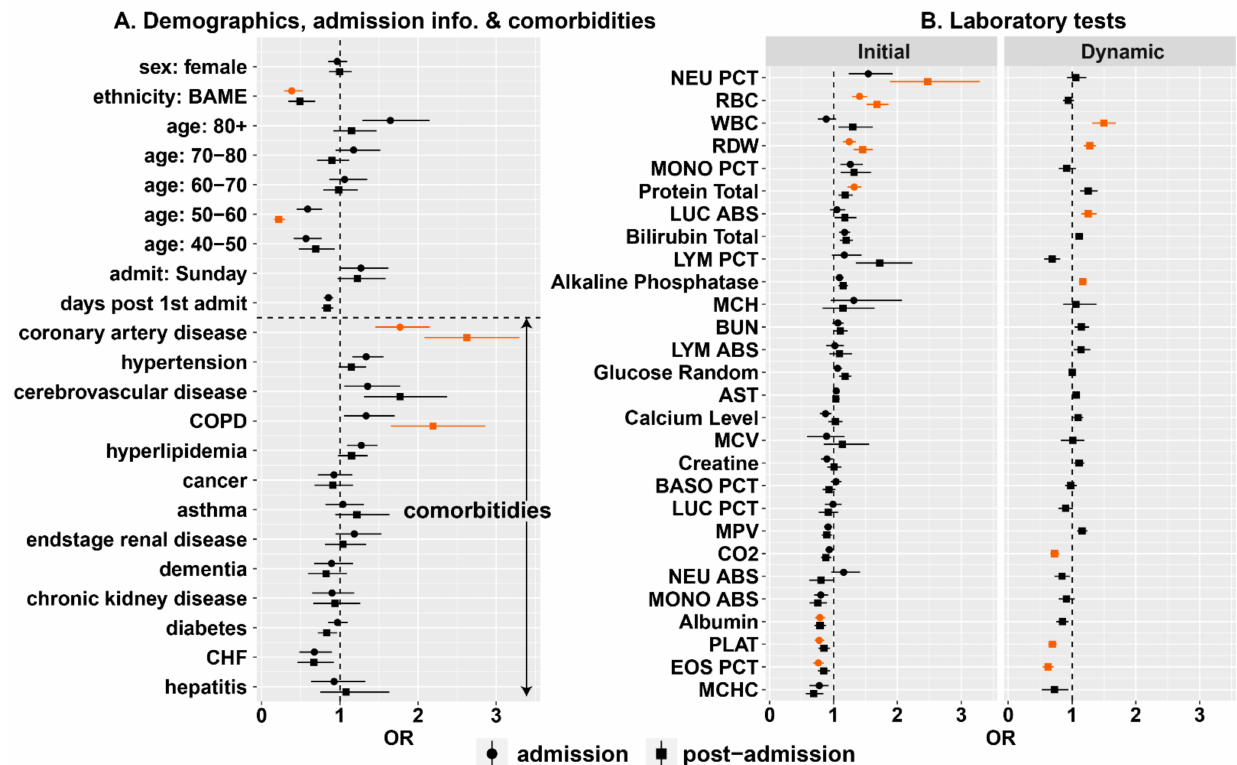
Figure 3. Estimated odds ratios for daily risk of death from Markov model: Panel ( A ) shows odds ratios (ORs) for demographic factors, variables associated with admission timing and comorbidities; Panel ( B ) shows ORs associated with lab values: both those upon admission (“Initial”) and % changes in lab values from these initial values (“Dynamic”). Marker types indicates the selection of regressors included in the model (see main text). Orange points indicate those odds ratios where the 5–95% posterior quantiles did not cross zero. Note, that the results for the lab values were obtained on data that had been standardized so that differences best reflect clinically relevant differences (see main text). (NEU PCT: neutrophils%, RBC: red blood cells, WBC: white blood cells, RDW: red cell distribution width, MONO PCT: monocytes%, LUC ABS: absolute large unstained cells count, LYM PCT: lymphocytes%, MCH: mean corpuscular hemoglobin, BUN: blood urea nitrogen, LYM ABS: absolute lymphocyte count, AST: aspartate aminotransferase, MCV: mean corpuscular volume, BASO PCT: basophils%, LUC PCT: large unstained cells%, MPV: mean platelets volume, NEU ABS: absolute neutrophil count, MONO ABS: absolute monocyte count, PLAT: platelets, EOS PCT: eosinophils%, MCHC: mean corpuscular hemoglobin